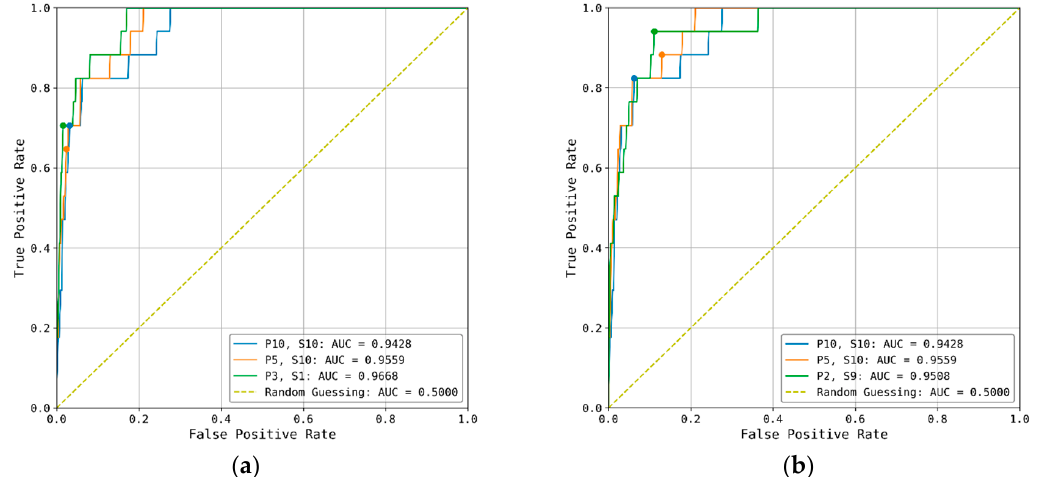
Figure 5. Seattle area ROC curves showing the performance of different threshold formats optimized with: ( a ) threat score; ( b ) optimal point statistic. Optimal thresholds for each ROC curve are shown as the solid dots. Recent rainfall and Saturation for N days shown as P N and S N , respectively.